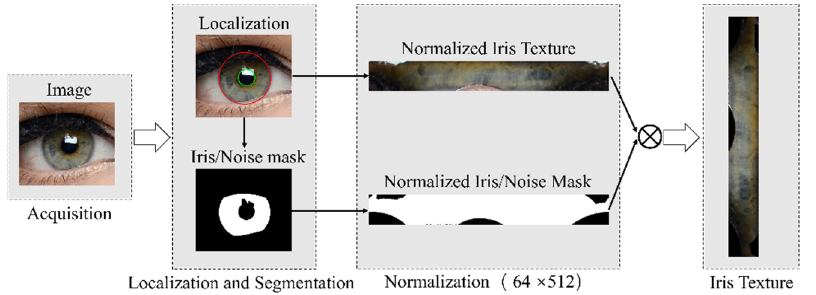
Figure 1. Iris ‐ image preprocessing for the iris ‐ recognition system, ⊗ presents the pixel ‐ wise mul ‐ tiplication.